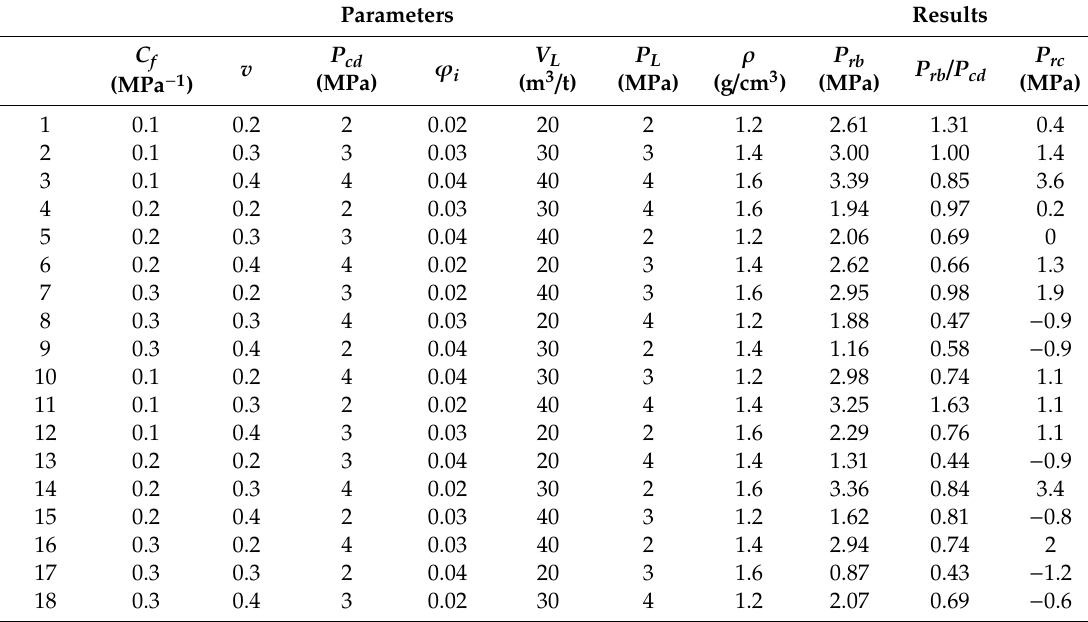
Table 3. The orthogonal test design and